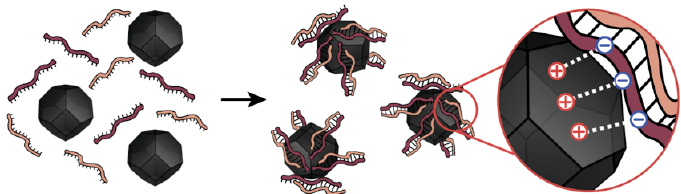
Figure 5. The proposed mechanism of siRNA hybridization on the surface of MNPs. Due to the electrostatic interaction between small positively charged MNPs and negatively charged siRNA strands, there is a local increase in the concentration of siRNA on the surface, leading to their hybridization.